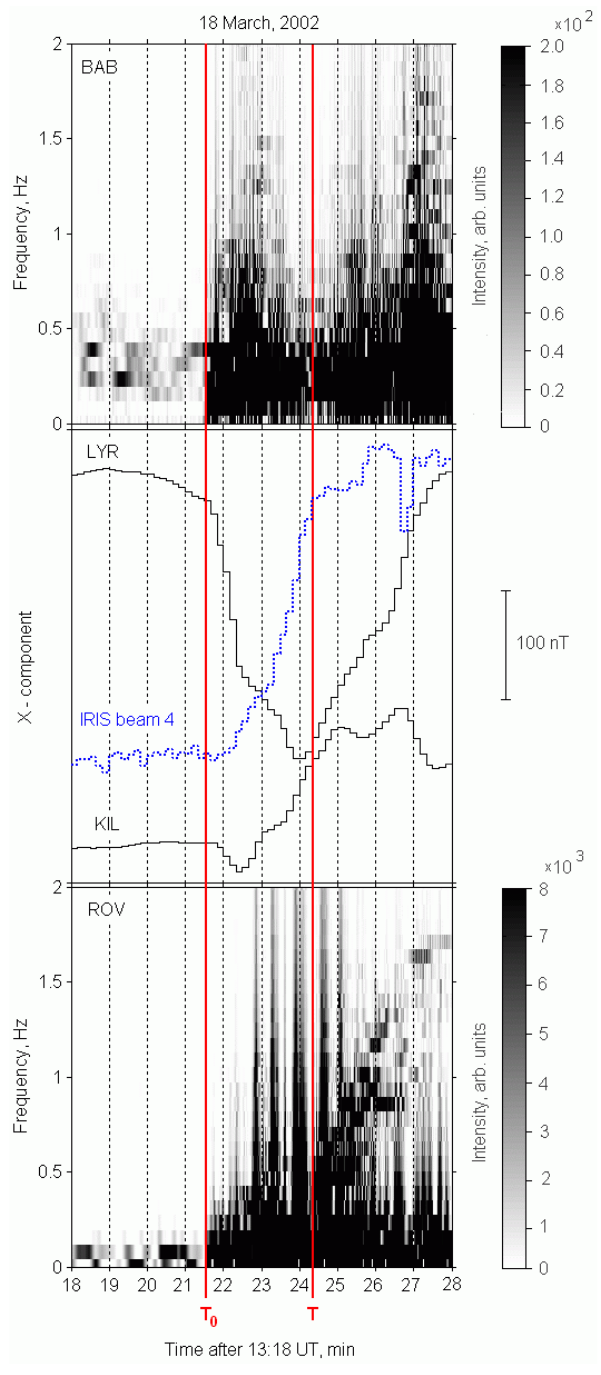
Fig. 5. Disturbances in the frequency band above 0.1Hz (upper and lower panels) and SC-initiated magnetic variations at LIR and KIL and sudden commencement absorption (central panel). the ground. Based on this observation, we use the riome- ter data to indicate precipitation in the wide energy range for the other SWPP events when IMAGE satellite data were not